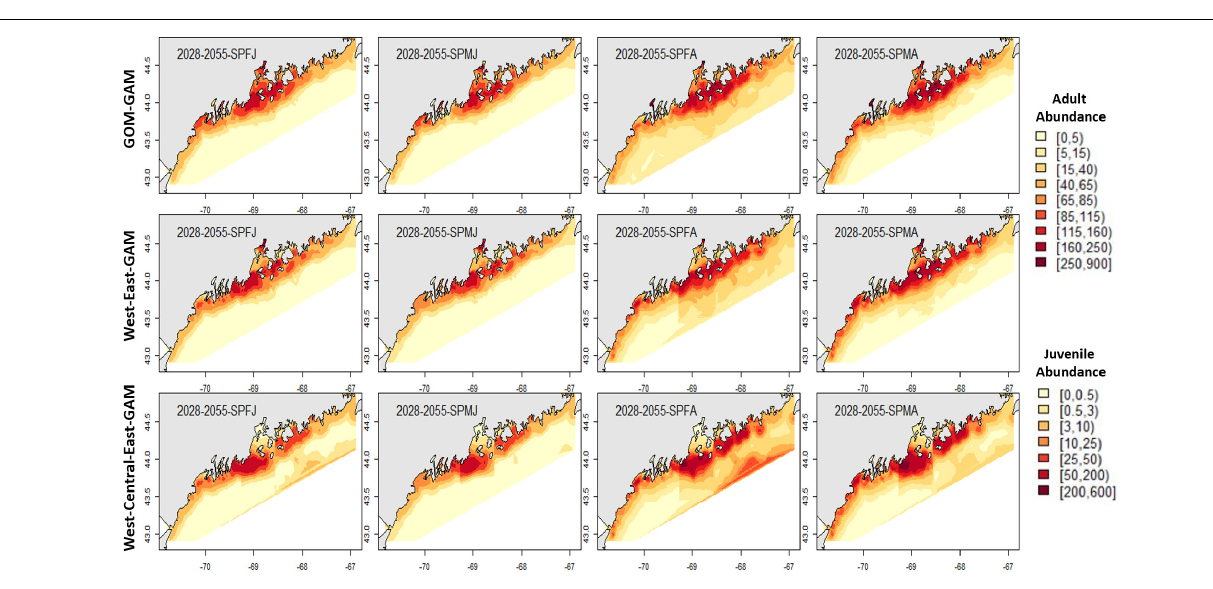
FIGURE 7 | Forecasted spring American lobster estimated spatial distribution for the time period 2028–2055. See Figure 4 for figure